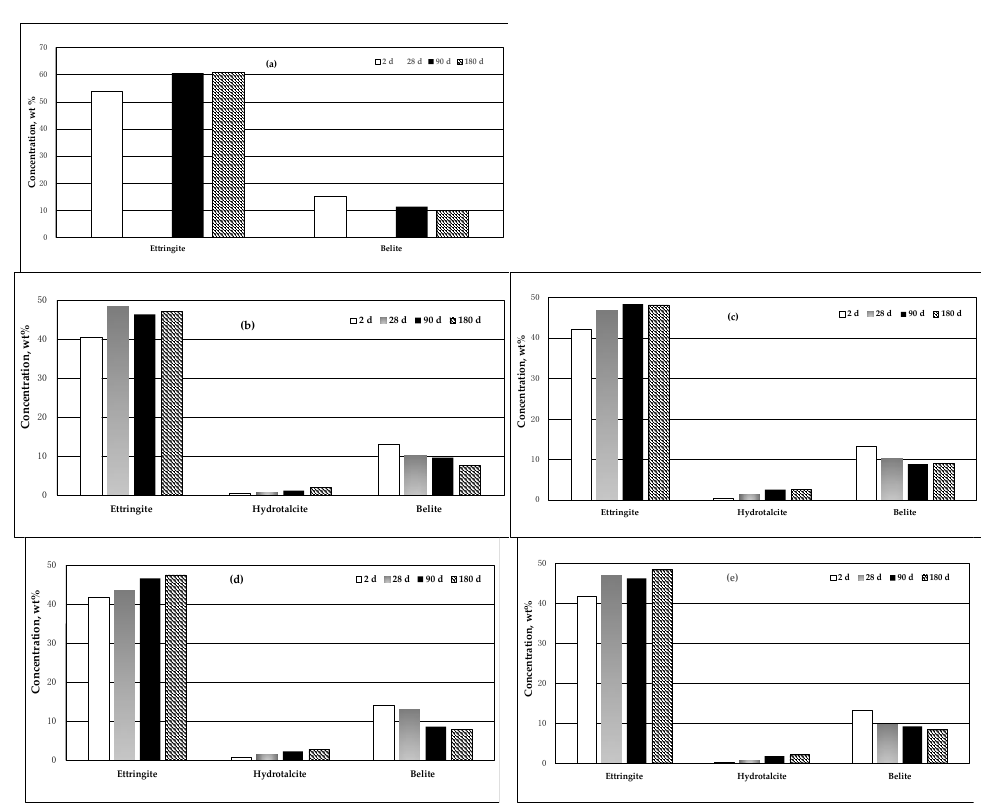
of curing; however, the presence of belite was found in the five systems at all the investi- gated curing periods, and its concentration value gradually decreases with the increase in curing times.